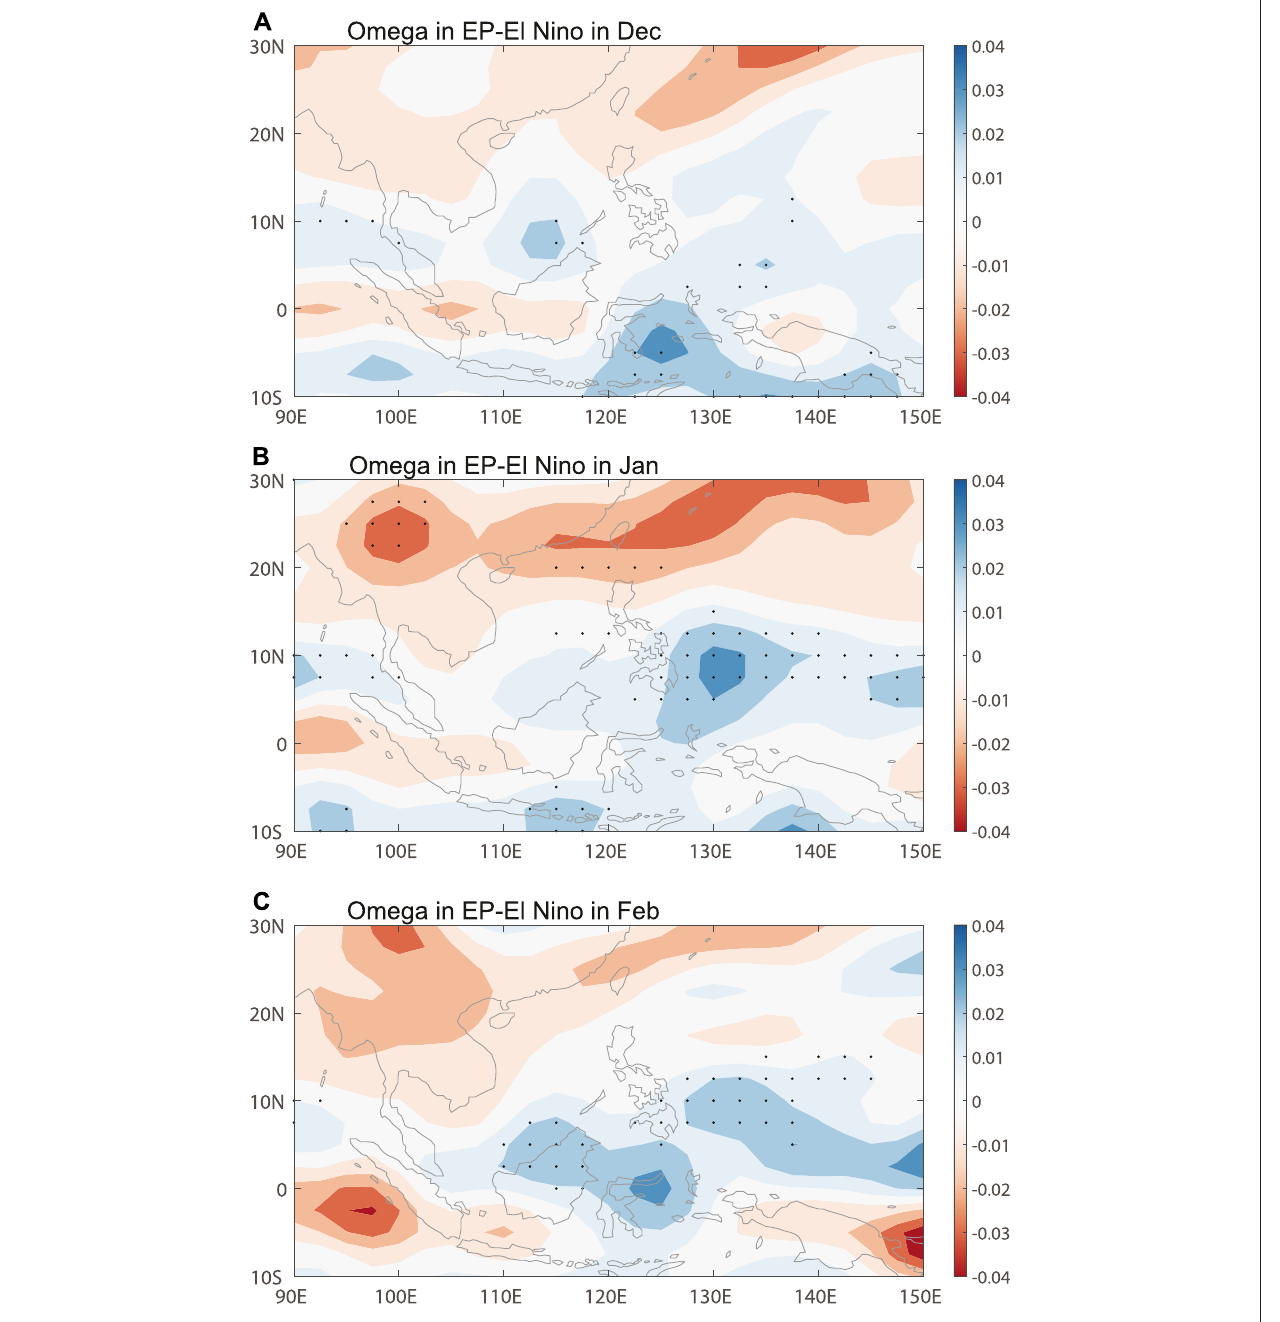
FIGURE7| Verticalvelocity anomalies (units:Pa s − 1 )duringEl Niñomature phasesin (A) December, (B) January,and (C) February.Dottedareasindicatethe0.05 signi fi cance level.